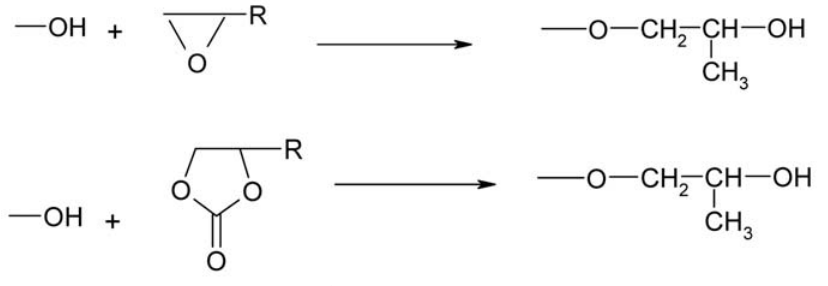
Scheme 2. Reaction of oxirane and alkylene carbonate with hydroxyl